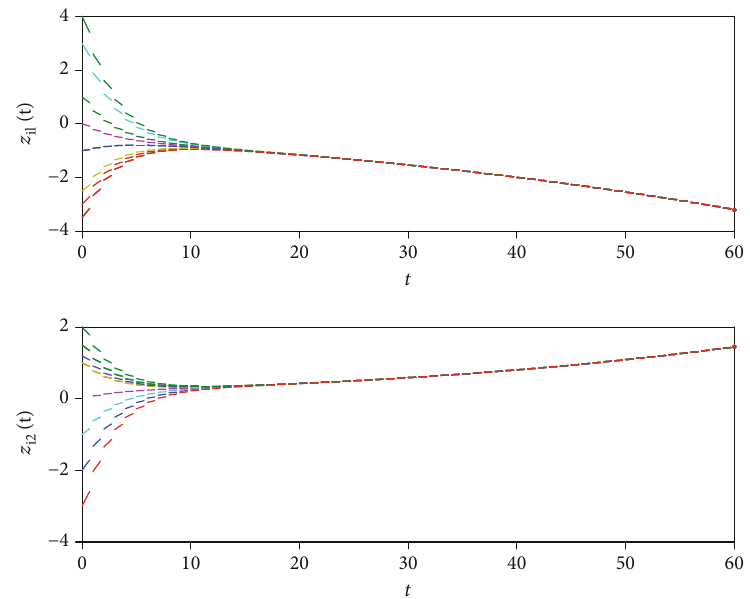
Figure 1: Error z